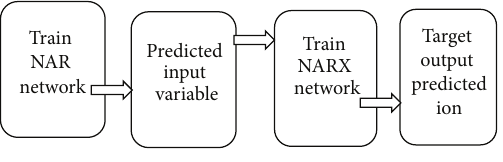
Figure 4: Dependency